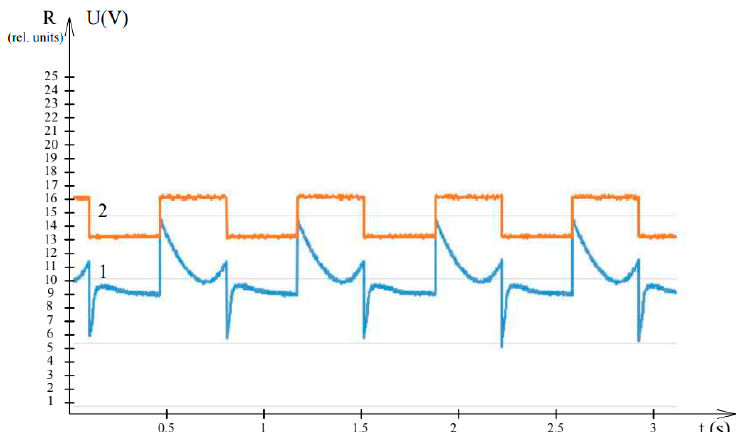
Figure 5. Plotted graph based on the oscillogram obtained by the GDS-71022 oscilloscope. Forced synchronization of fluctuations in the concentration of the dispersed phase of the ferrocolloid. Beam 1—optical signal: time dependence of the intensity of reflected light; beam 2—pulse voltage U = 2.5 V, frequency ω p = 1.35 Hz.